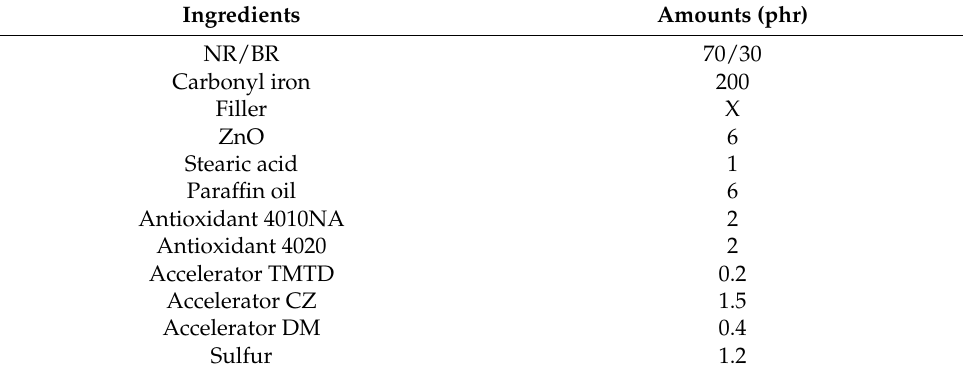
Figure 5. Mechanism diagram of SiCB + PDA synergistic modification of BF H .